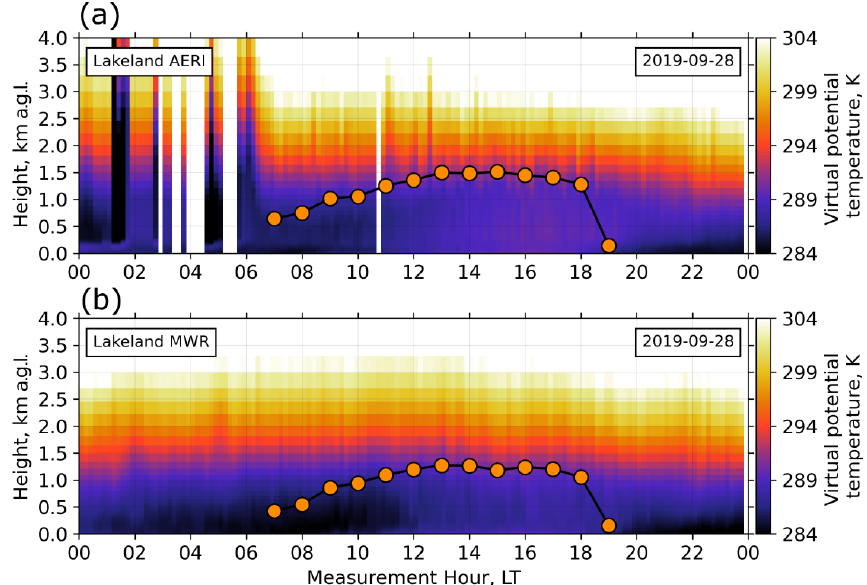
Figure 3. Time–height cross section of retrieved virtual potential temperatures for the AERI (a) and the MWR (b) at the Lakeland site for 28 September 2019. Overlaid on both panels are PBLHs (orange dots) estimated by applying the parcel method to the corresponding hourly averaged profiles between sunrise (around 07:00LT) and sunset (around